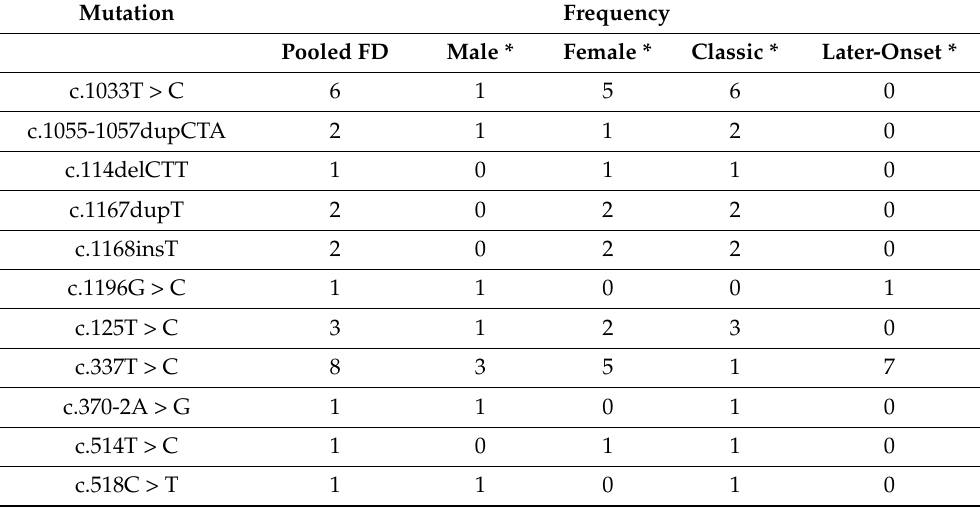
Table 2. α -galactosidase gene (GLA) mutations observed in the pooled Fabry disease group and respective